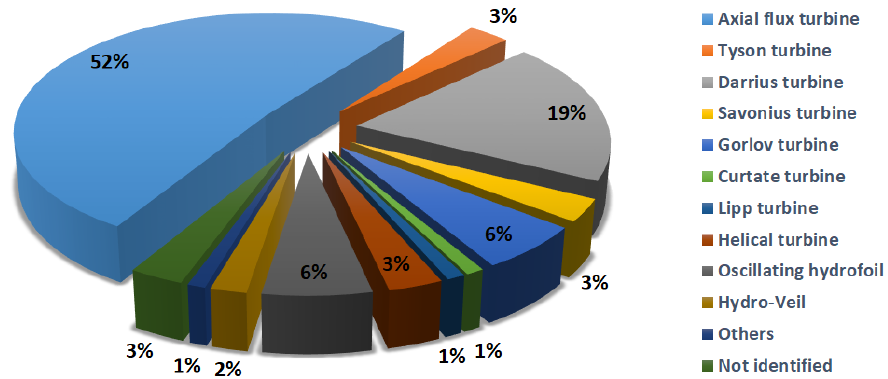
Figure 11. Turbine design, worldwide trend [19]. c (cid:13) Reproduced with permission from SEENEOH, 2017.